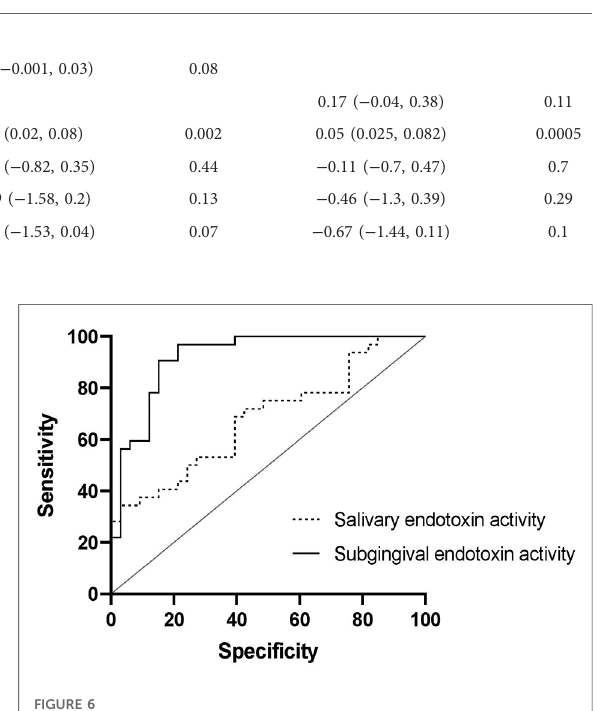
FIGURE 4 Comparison of salivary endotoxin activity levels in periodontitis patients before and after periodontal treatment.